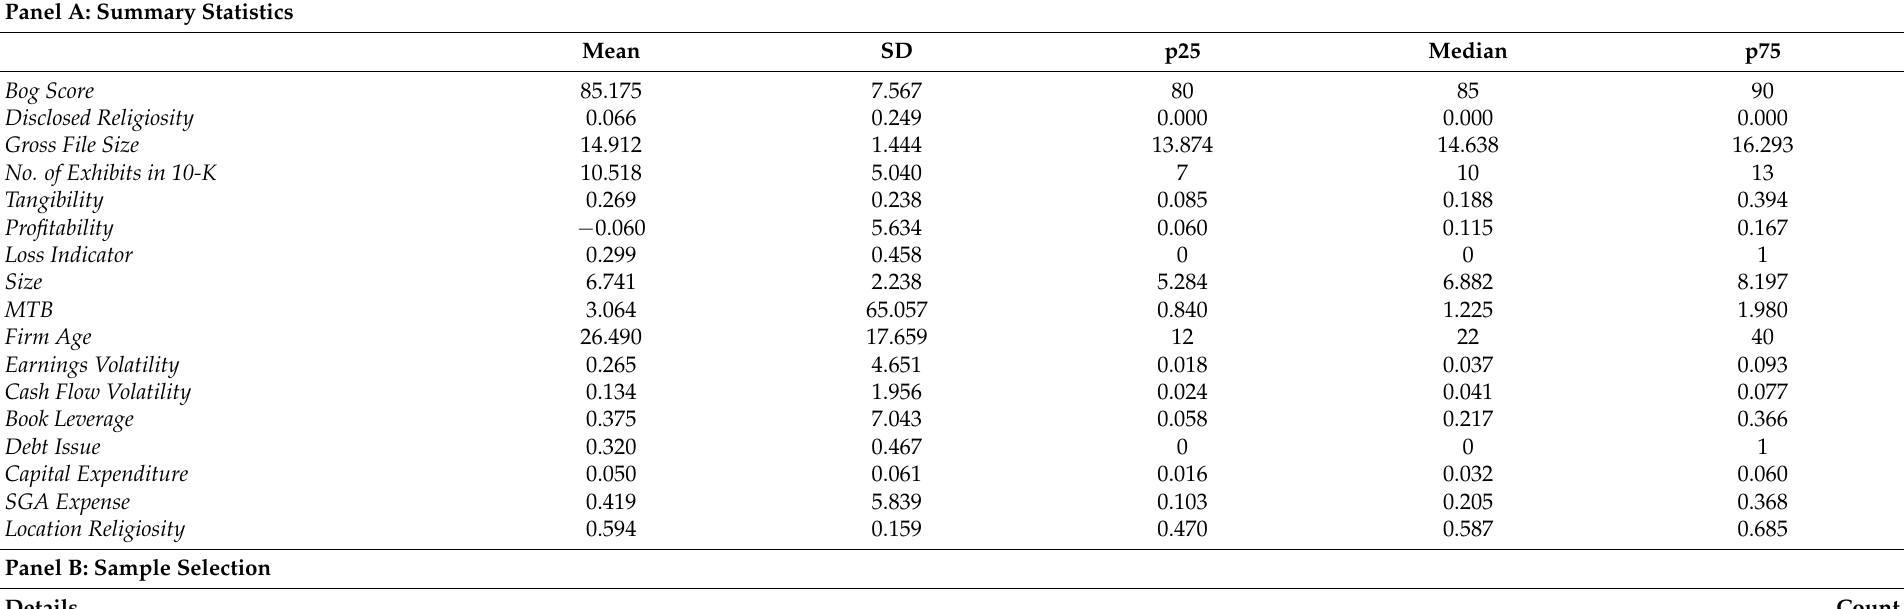
Table 1. Summary statistics, sample selection and Pearson